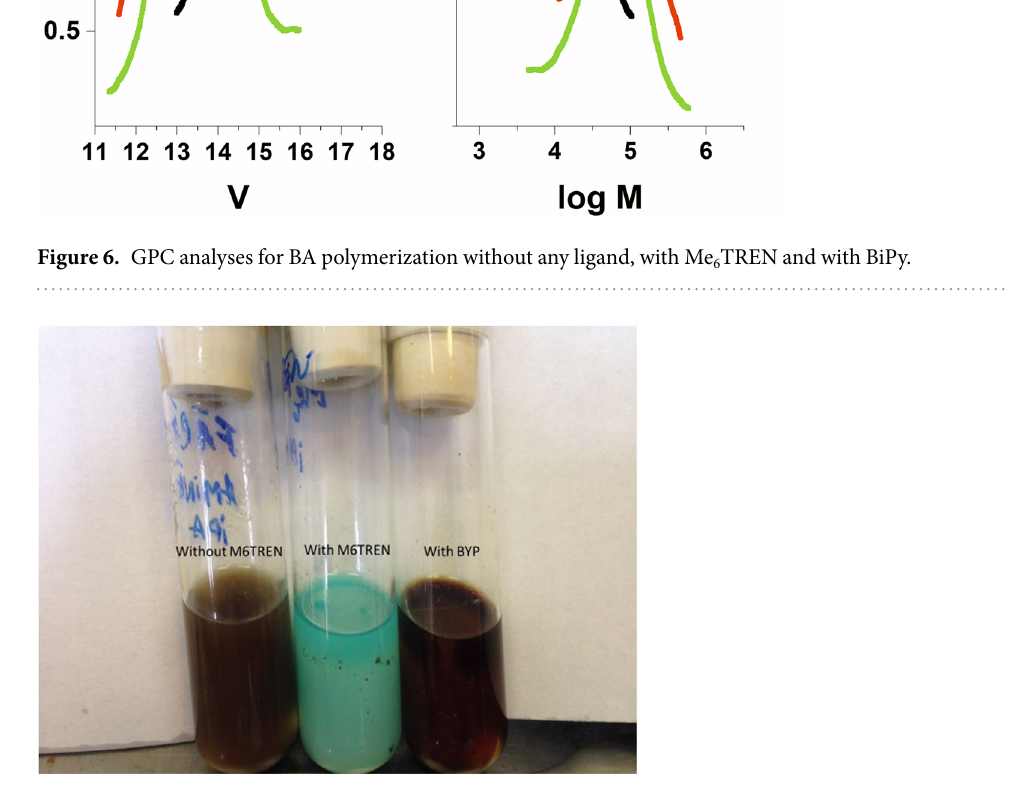
Figure 7. Visualization of BA polymerization using CuNPs/SiO 2 catalyst and a) no ligand, b) Me 6 TREN and c)